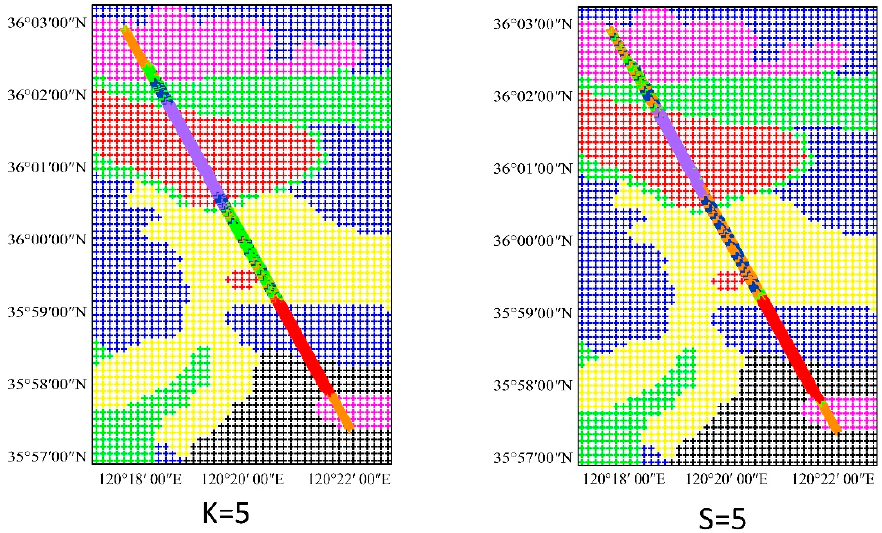
Figure 10. The classification results of SOM and K-medoids for five categories.